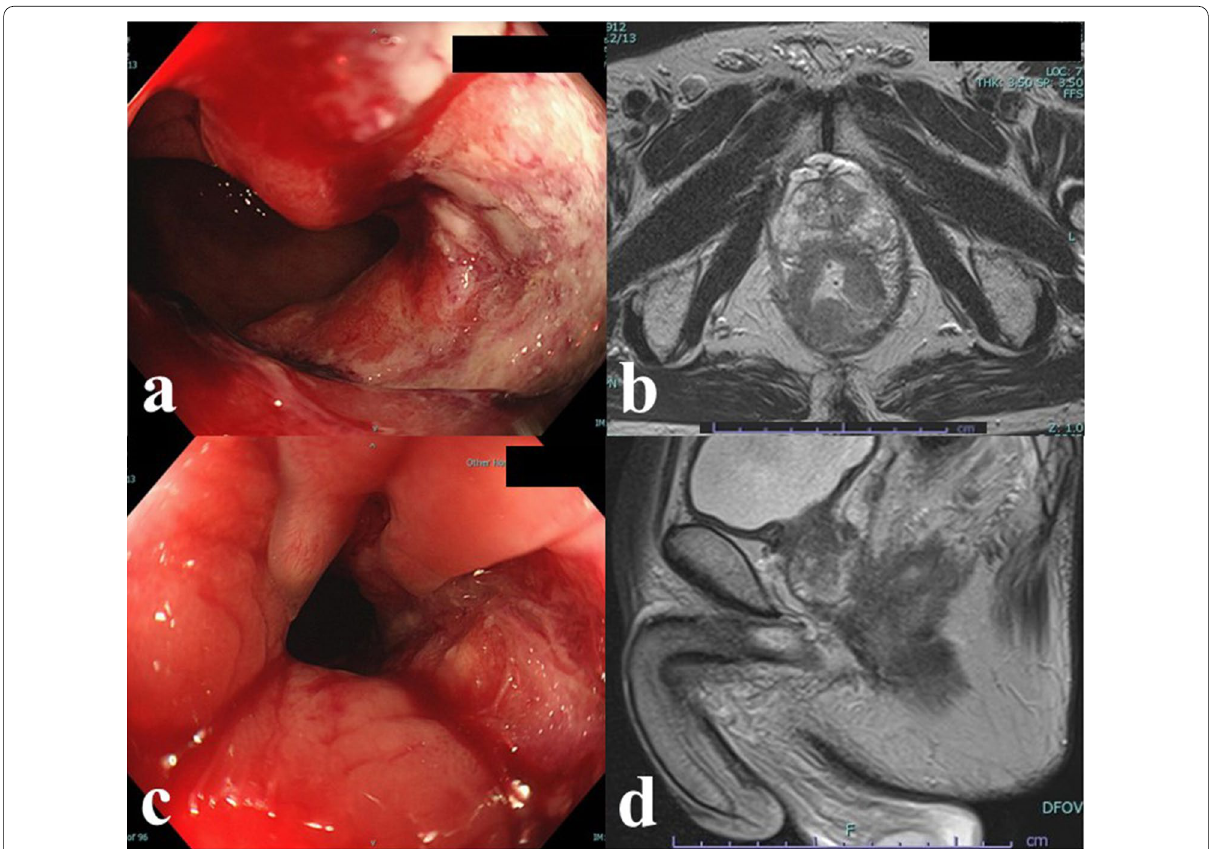
Fig. 1 a Colonoscopy image and b magnetic resonance image at the time of the initial diagnosis. The ulcerative tumor is located in the lower rectum and proctodeum. Biopsy revealed tubular adenocarcinoma. c Colonoscopy image and d magnetic resonance image after neoadjuvant chemoradiotherapy. Partial response was observed. However, the prostate was still